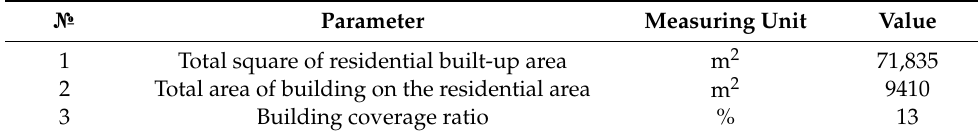
Table 2. Main average urban parameters of a typical residential area.